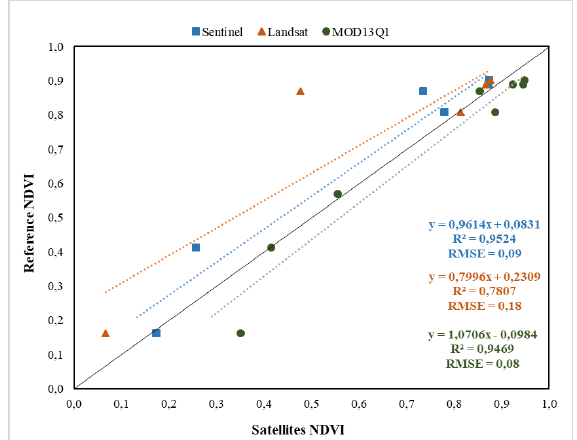
Figure 5. Normalized Difference Vegetation Index (NDVI) data for soybean crop obtained from different orbital sensors compared to surface measured data. Carazinho/RS, 2017/18